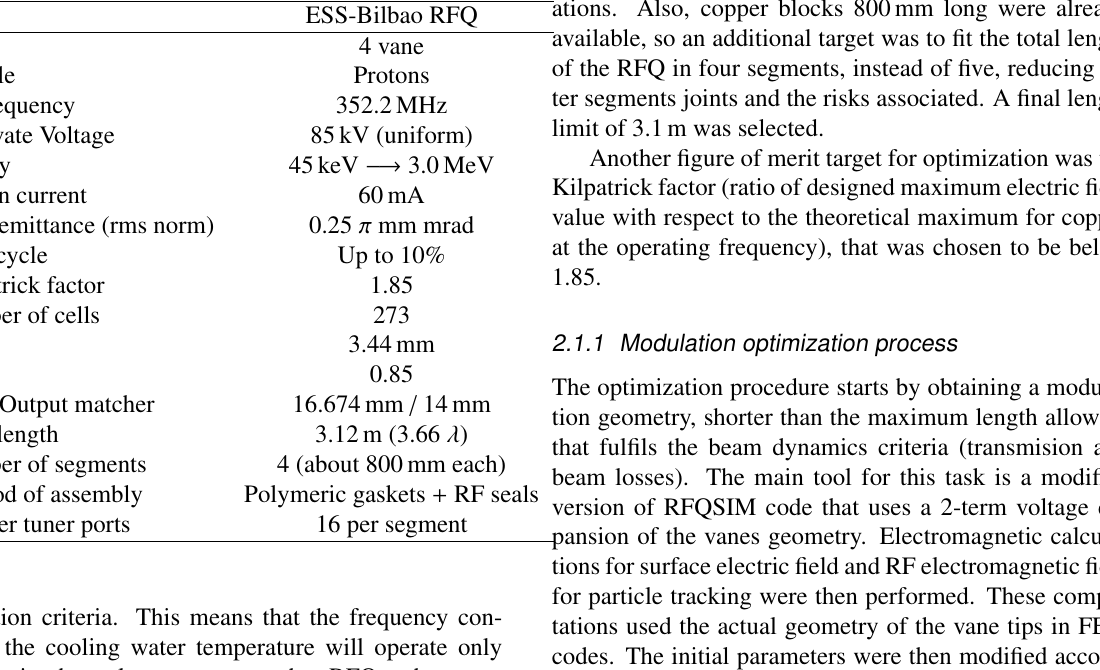
Table 1. ESS-Bilbao RFQ Main